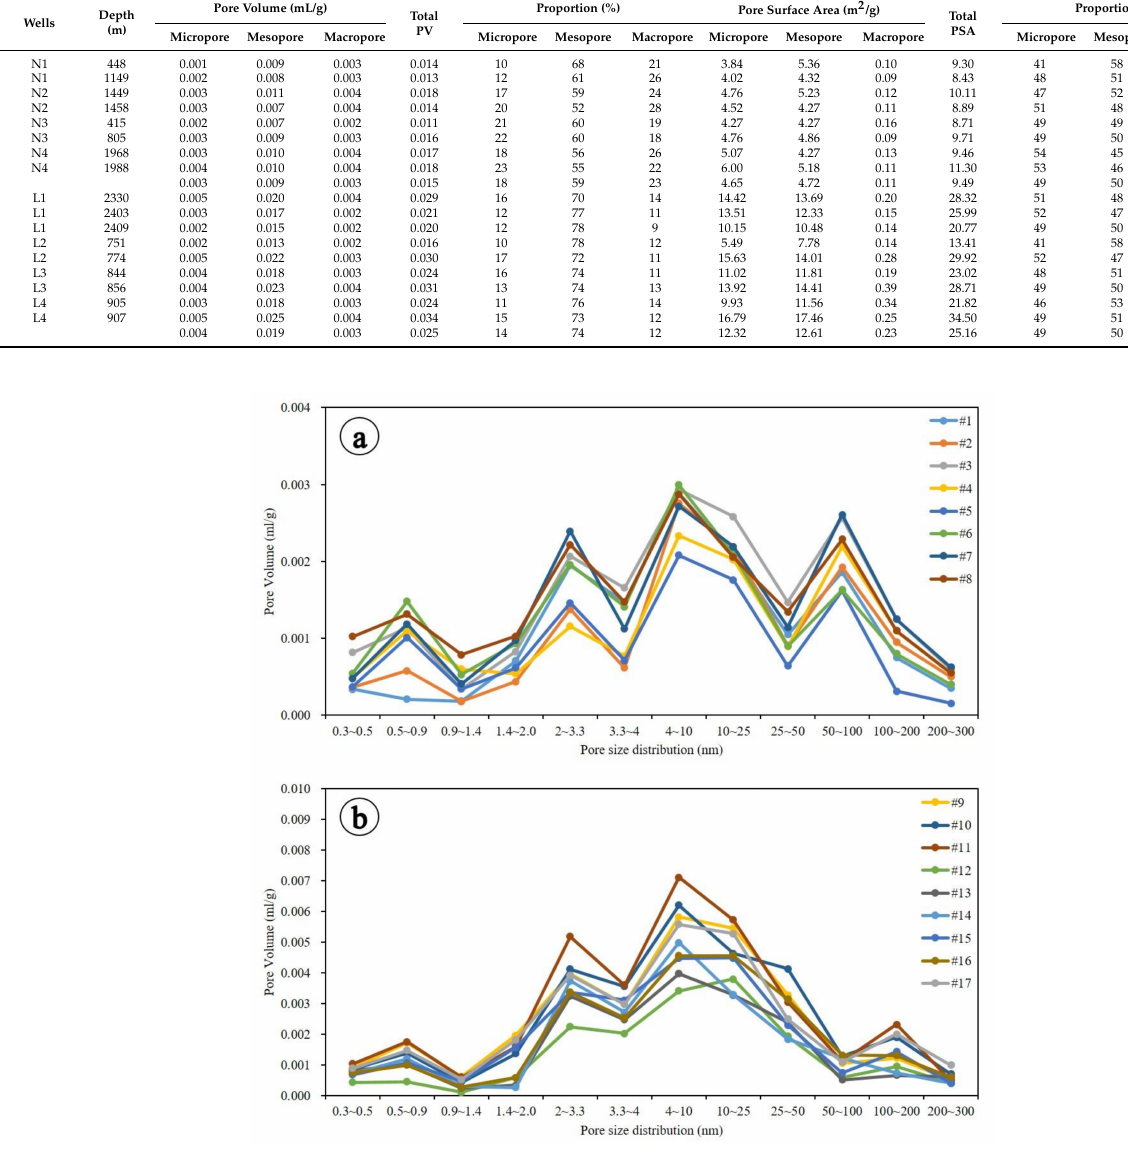
Figure 5. The PVs of lower Cambrian shale and lower Silurian shale analyzed by N 2 adsorption experiments: ( a ) PVs of lower Cambrian shale samples (#1–#8) and ( b ) PVs of lower Silurian shale samples